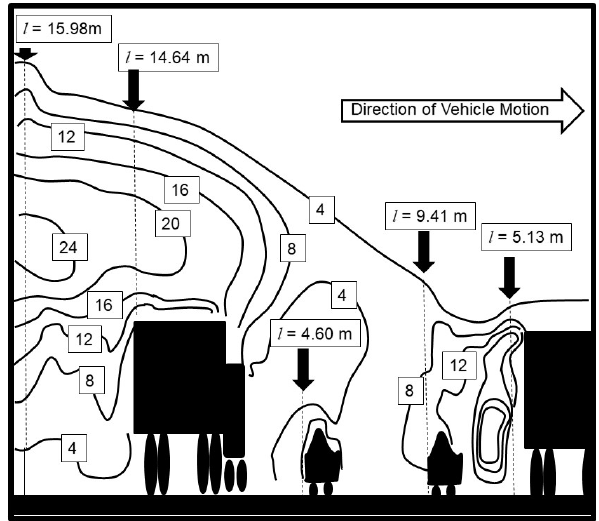
Figure 1. Example of length scales associated with an ensemble of vehicles (after Y. Kim et al., 2016; Fig. 14). TKE contours along dashed lines were extracted and fit to Eqs. (1) and (2) for Table 1. Note that the length scale of turbulence immediately behind the leading vehicle, a large transport truck, is only 5.13m, while the length scale immediately behind the trailing vehicle in the ensem- ble (an identical transport truck) is